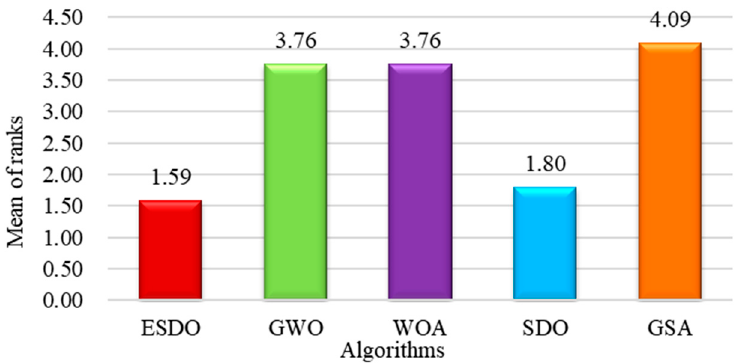
Figure 7. Mean of ranks of different algorithms.